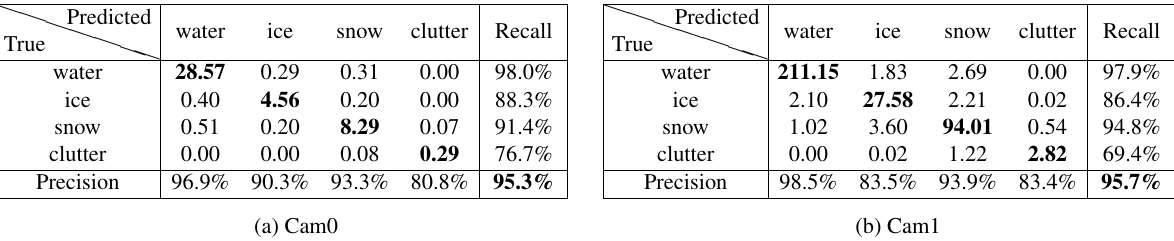
Table 1. Confusion matrices for the two webcam datasets. Units are millions of pixels, except for precision and recall. best among the target classes, regarding both recall and